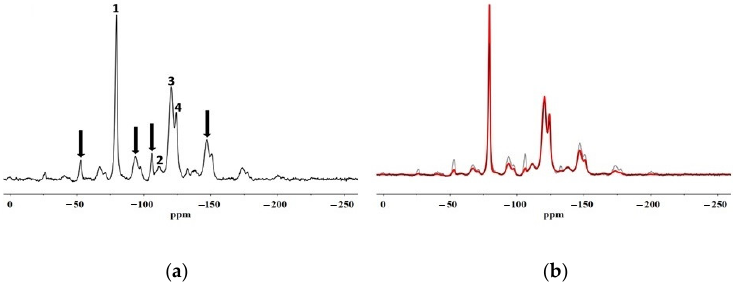
Figure 14. 19 F MAS NMR spectra of ( a ) Fluo AQ on stone; ( b ) Fluo AQ on stone (black) and Fluo AQ film (red). The symbol ( ↓ ) represents the spinning side bands.